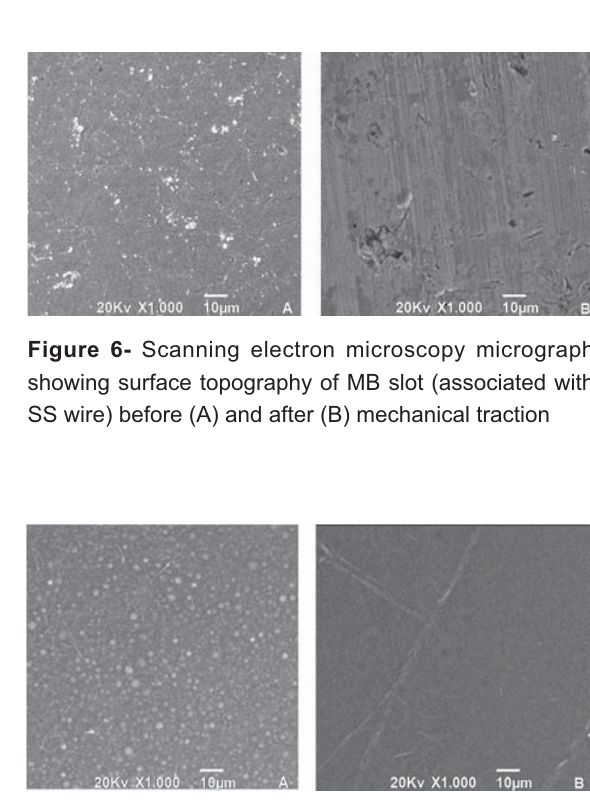
Figure 7- Scanning electron microscopy micrograph showing surface topography of PB slot (associated with SS wire) before (A) and after (B) mechanical traction